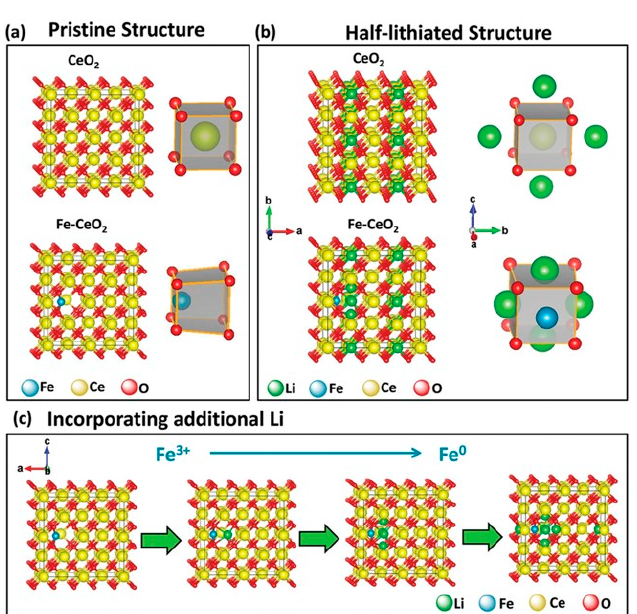
Figure 8. ( a ) Crystal structure of CeO 2 and Fe-CeO 2 and their local environments. ( b ) Prototype structure for a half-lithiated, ordered, Fe-free CeO 2 , and Fe-containing structure. ( c ) Prototype structures for incorporating additional Li within the structure of Fe-containing CeO 2 . Reproduced from Ma et al. [79].